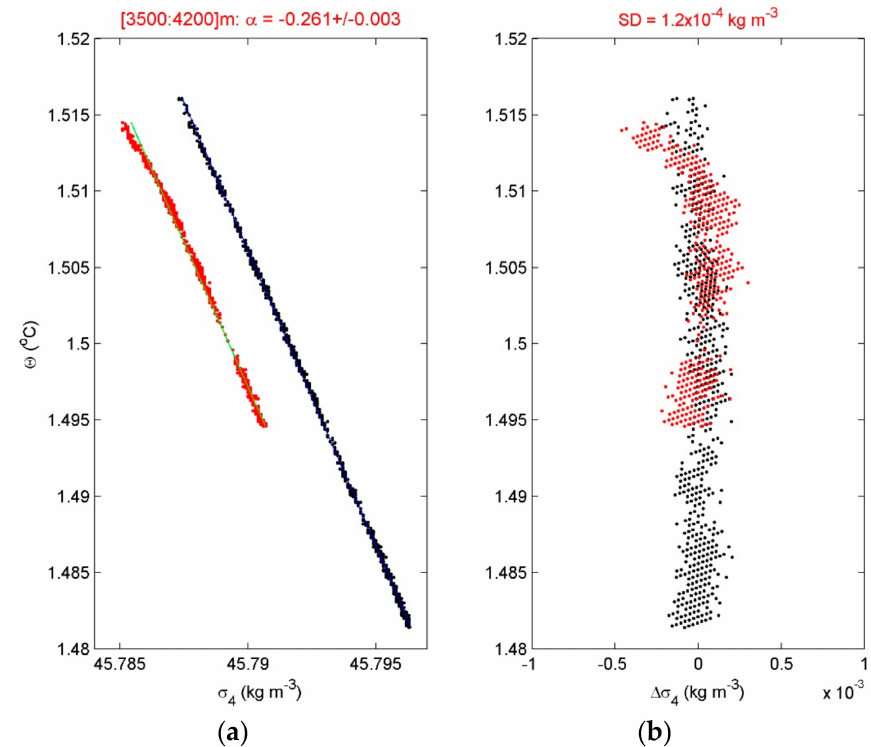
Figure 3. Conservative (~potential) temperature and density anomaly referenced to 4000 dbar relationship from shipborne CTD-data near abyssal hills in the near-equatorial south-Pacific DRISCOL area. ( a ) The mean slope fit is given in the left panel for CTD-observations before (red) and after (black) deployment. ( b ) Deviations from the